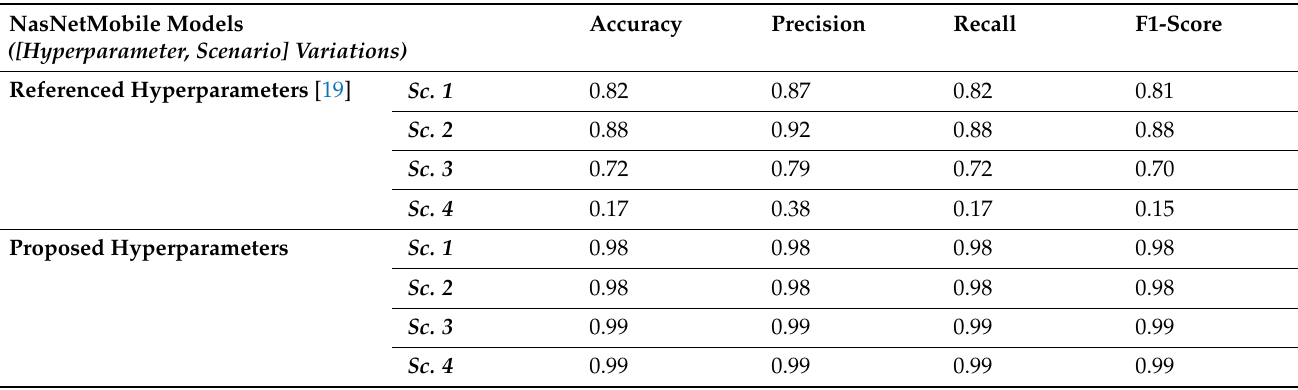
Table 3. Evaluation scores for developed NasNetMobile models.